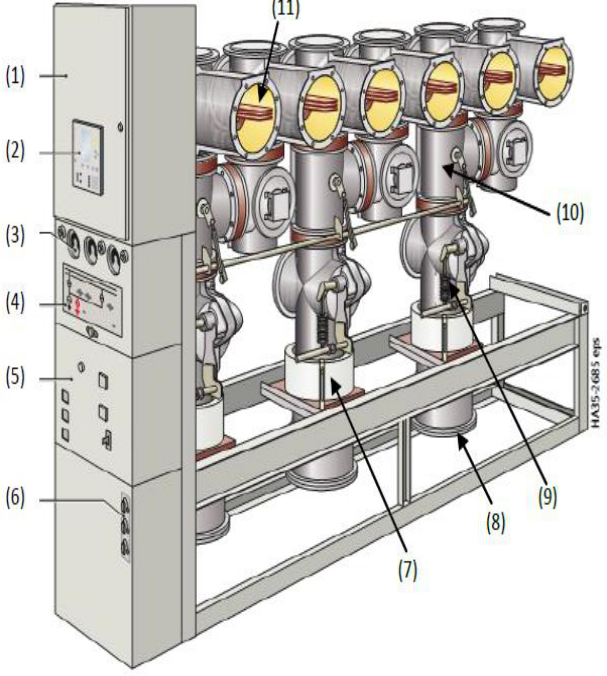
Figure 5. Example of GIS. 1. LV compartment. 2. Relays. 3. Gas density meter. 4. Single line diagram/semaphore indication. 5. CB operating mechanism. 6. Live indicator. 7. Current transformer. 8. Cable termination. 9. Circuit breaker. 10. Disconnectors/Isolators. 11. Busbar in SF 6 .